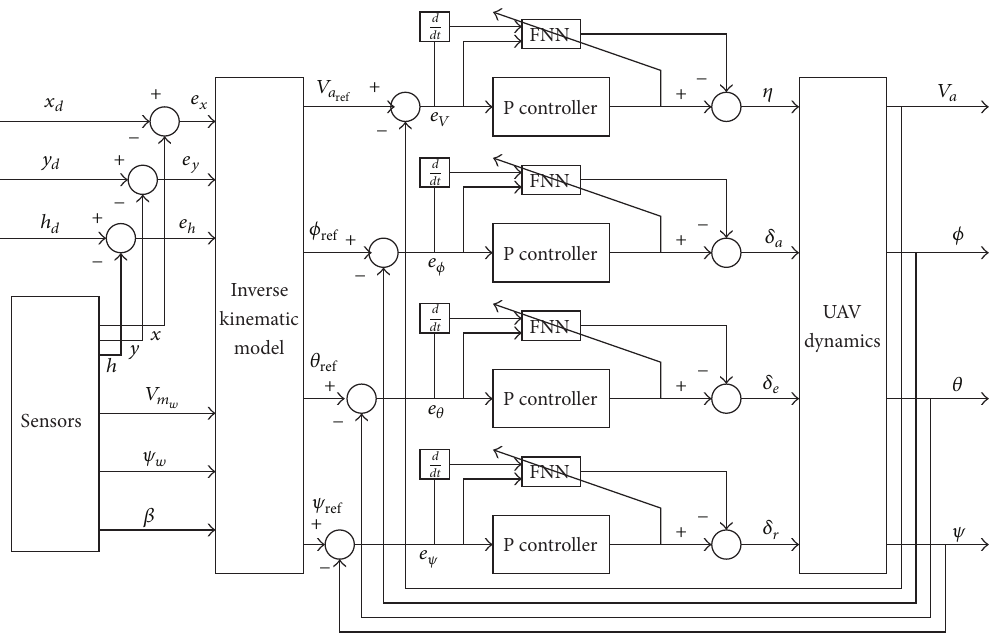
Figure 1: Block diagram of the proposed adaptive FNN control structure.